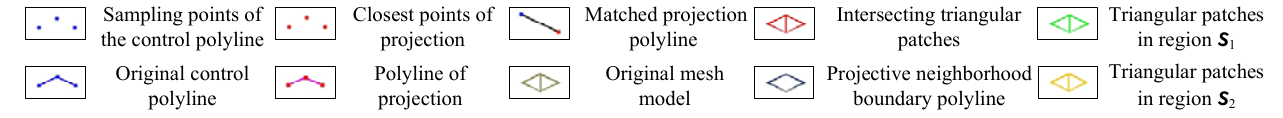
Figure 3. Schematic diagram of mesh reconstruction in the projective neighborhood. In Step 2, according to the position of the closest projection point (i.e., deformation point) of the control point to the triangular mesh model, it could be divided into three cases, namely, the vertex, the edge, and the patch of the triangular mesh. Therefore, different methods needed to be adopted to determine the triangular patches, as shown in Figure 4. triangular patches of the mesh vertex within a circle needed to be added to the set 𝑻 (cid:2869) . gular patches of the mesh edge needed to be added to the set 𝑻 (cid:2869) . Thirdly, if the defor ‐